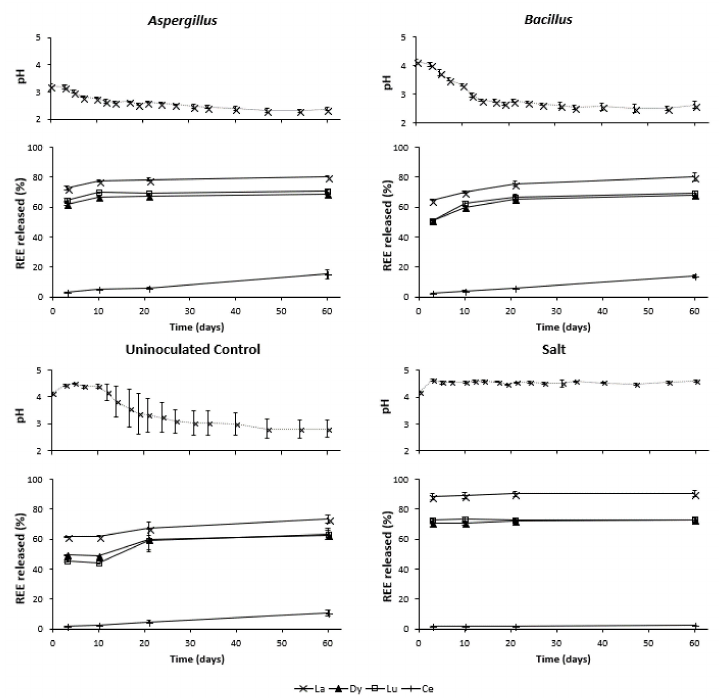
Figure 2. Changes in pH (top section of graphs) and release of La, Dy, Lu and Ce (bottom sections of graphs) over the duration of the experiment. Day zero pH measurement was taken 1 h after mixing IAD. The chemical analysis starts from day three as first data point. Error bars are standard deviation of triplicate